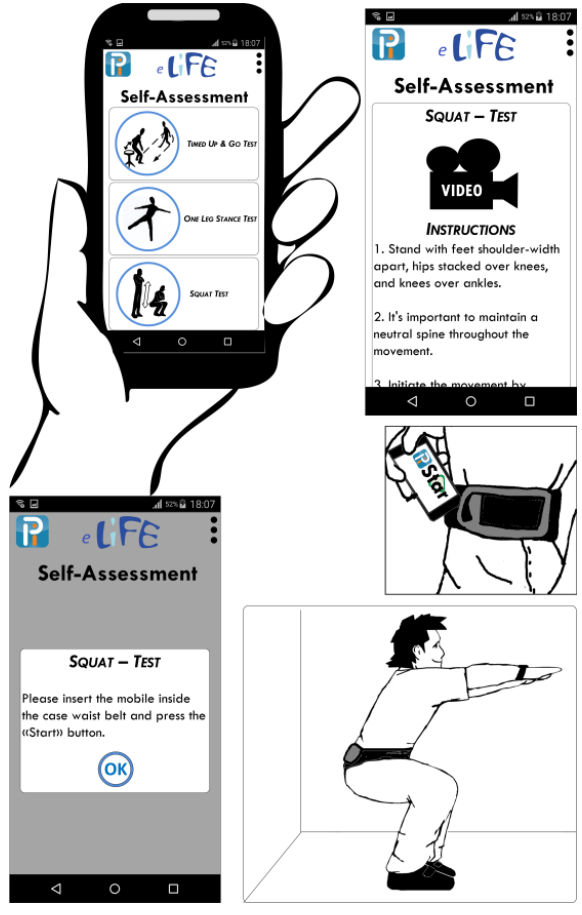
Figure 2. Example of a self-assessment test application for physical performance performed while having a smartphone worn in a belt around the waist. From a smartphone application different tests of physical function can be chosen, demonstrated through a video clip, and instructed by use of a virtual instructor.